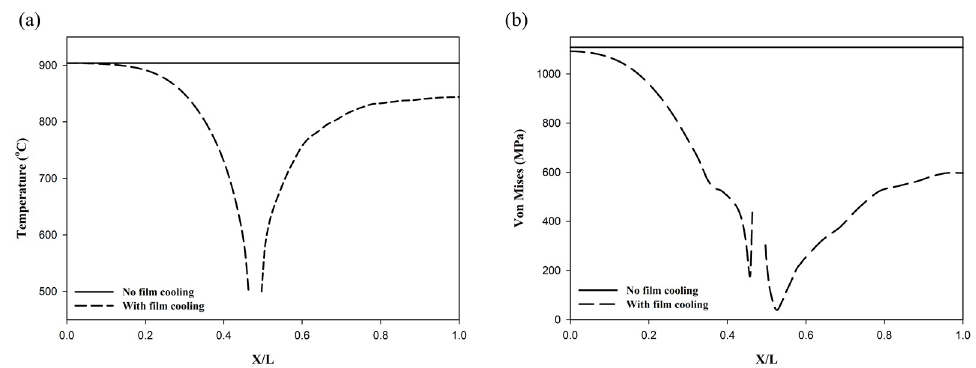
Figure 4. ( a ) Temperature distribution along the BC top surface at the initial stage and ( b ) von Mises stress distribution along the BC top surface during cooling time.